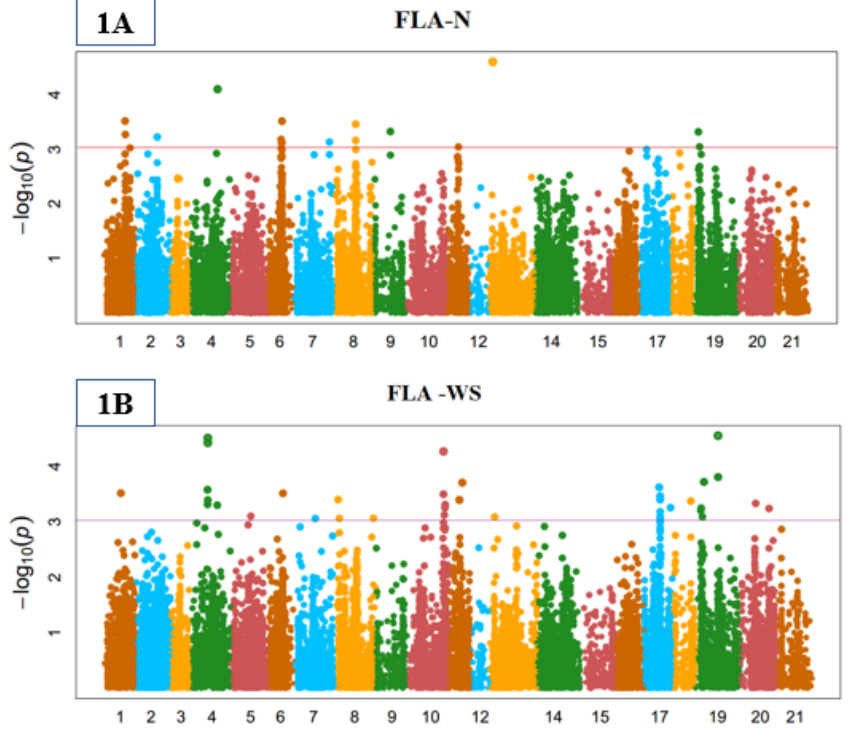
Figure 1. Manhattan plot of flag leaf area (FLA) under normal (N) ( A ) and water shortage (WS) ( B ) conditions. Manhattan plots showing the location of significant SNPs and − log10( p ) associated with flag leaf area in bread wheat under normal and water shortage conditions. The red horizontal line on Manhattan plot entitles the threshold level ( p < 0.0001) of significance for SNPs with this trait.